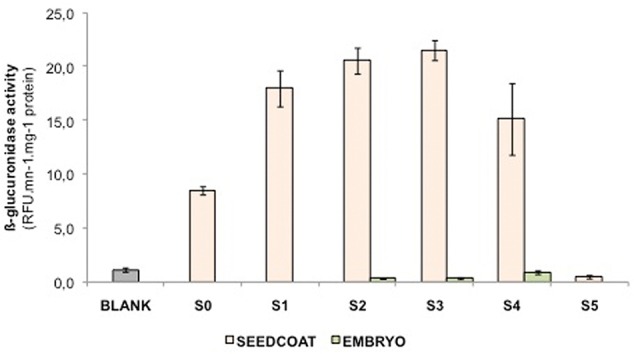
GUS activities from embryo and seed coats in the developing seeds of flax plants stably transformed with an 895-bp LuPLR1 promoter-GUS reporter gene construct are shown. S0, S1, S2, S3, S4, and S5 correspond to ca 4, 10, 16, 22, 28, and 40 days after flowering, respectively, and WT represents the activity measured in an S3 wild type whole seed.